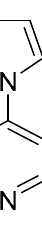
Figure 6. Quinoline derivatives with insecticide activity.